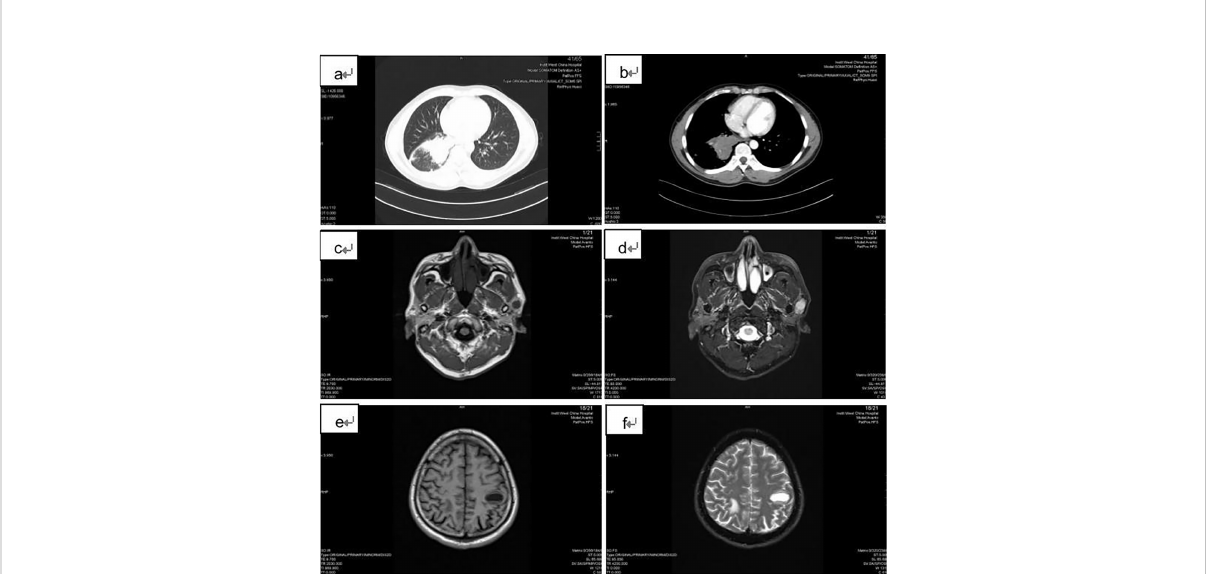
FIGURE 1 Imaging fi ndings of the patient. (A) and (B) : the chest CT showed a 6.4 cm x 5.2 cm mass at the right hilar; (C) and (D) : T1 and T2 weighted head MRI images showed the preauricular mass located at the parotid gland; (E) and (F) : T1 and T2 weighted head MRI images revealed the brain